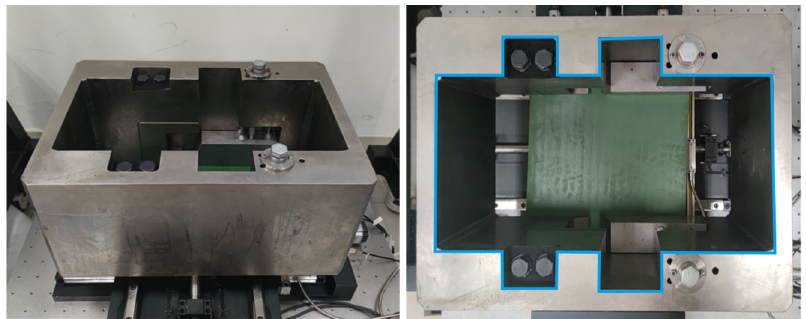
Figure 2. The physical photo of the cutter holder. The blue curve on the surface of the cutter holder on the right is its inside contour. on the right is its inside